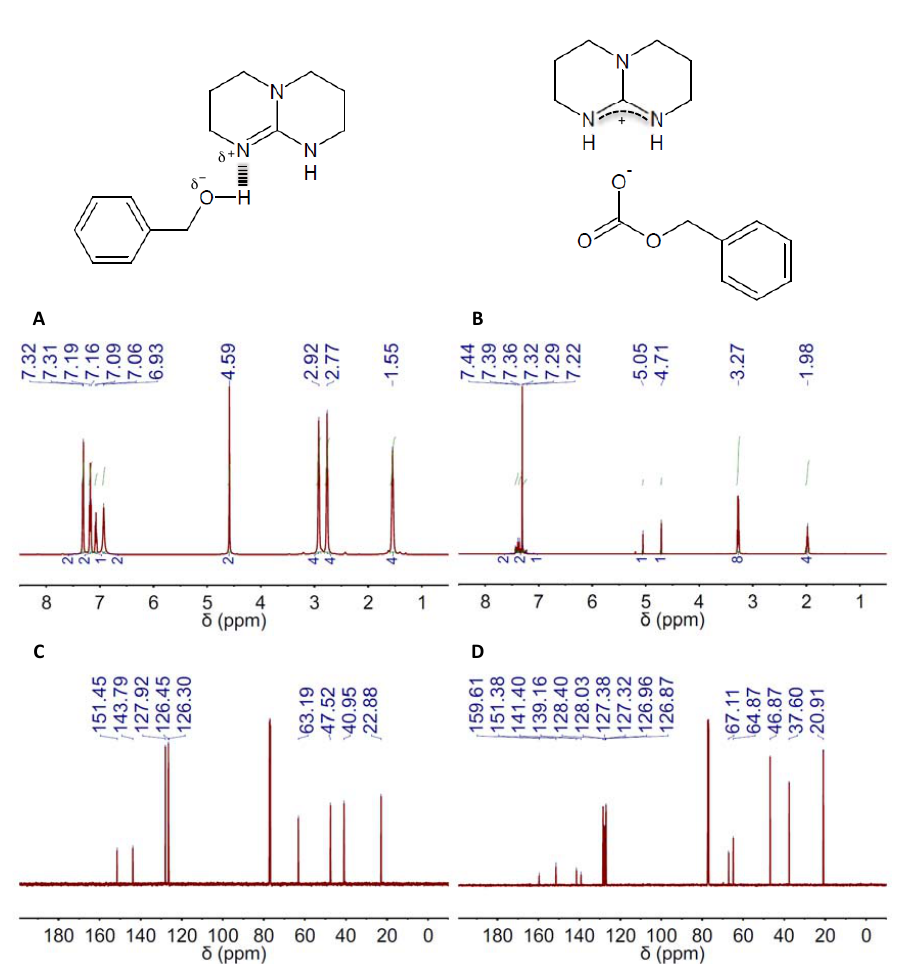
(cid:6)(cid:24)(cid:22)(cid:34)(cid:31)(cid:20)(cid:60)(cid:47)(cid:55) (cid:92) (cid:61) (cid:8)(cid:92)(cid:27)(cid:40)(cid:30)(cid:92) (cid:61)(cid:63) (cid:3)(cid:92)(cid:14)(cid:13)(cid:18)(cid:92)(cid:45)(cid:42)(cid:31)(cid:29)(cid:46)(cid:44)(cid:27)(cid:92)(cid:82)(cid:38)(cid:31)(cid:32)(cid:46)(cid:92)(cid:27)(cid:40)(cid:30)(cid:92)(cid:44)(cid:35)(cid:33)(cid:34)(cid:46)(cid:92)(cid:29)(cid:41)(cid:38)(cid:47)(cid:39)(cid:40)(cid:45)(cid:78)(cid:92)(cid:44)(cid:31)(cid:45)(cid:42)(cid:31)(cid:29)(cid:46)(cid:35)(cid:48)(cid:31)(cid:38)(cid:51)(cid:83)(cid:92)(cid:41)(cid:32)(cid:92)(cid:46)(cid:34)(cid:31)(cid:92)(cid:4)(cid:5)(cid:19)(cid:92)(cid:29)(cid:41)(cid:39)(cid:42)(cid:41)(cid:45)(cid:31)(cid:30)(cid:92)(cid:41)(cid:32)(cid:92) Figure 2. 1 H and 13 C NMR spectra (left and right columns, respectively) of the DES composed of 2,3,4,6,7,8-hexahydro-1 H -pyrimido[1,2- a ]pyrimidine (TBD) and BA in a 1:1 molar ratio, e.g., TBD(1):BA(1), before ( A , C ) and after ( B , D ) CO 2 absorption. The chemical structures of both the DES resulting from H-bond interaction between TBD and BA in the DES and the salt formed upon CO 2 absorption on DES are also